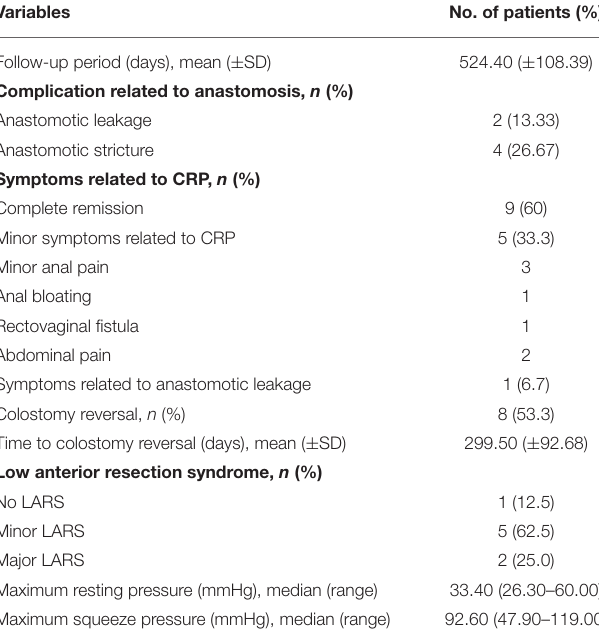
TABLE 3 | The follow-up of patients underwent the surgical